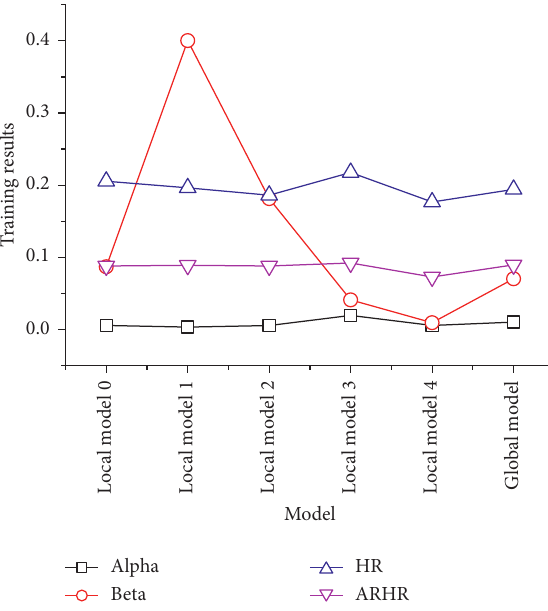
Figure 7: Training results of the model.